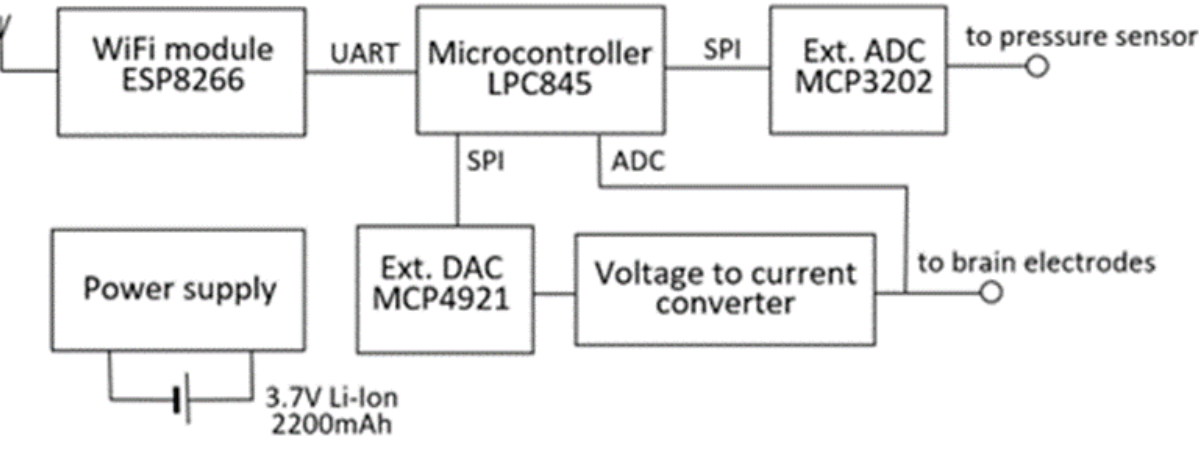
Figure 1. Parts of the measurement system.